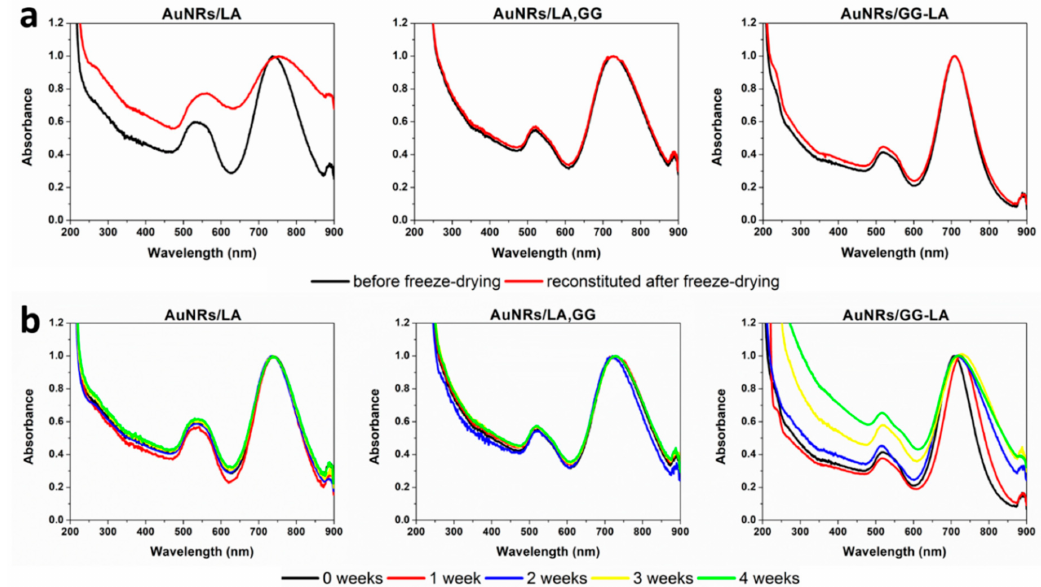
Figure 4. ( a ) VIS–NIR spectra before (black) and after (red) freeze-drying of AuNRs / lipoic acid (LA) (left), AuNRs / LA,GG (center), and AuNRs / GG-LA (right) in bidistilled water dispersion; ( b ) VIS–NIR spectra acquired every 7 days up to 1 month of AuNRs / LA (left), AuNRs / LA,GG (center), and AuNRs / GG-LA (right) in bidistilled water